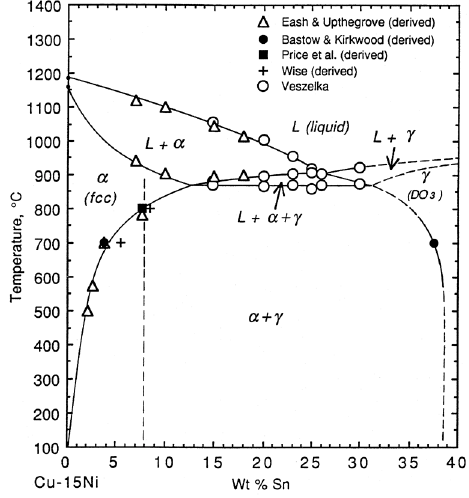
Figure 2. Cu–Ni–Sn ternary phase diagram (Ni fixed at 15 wt%) [12] .